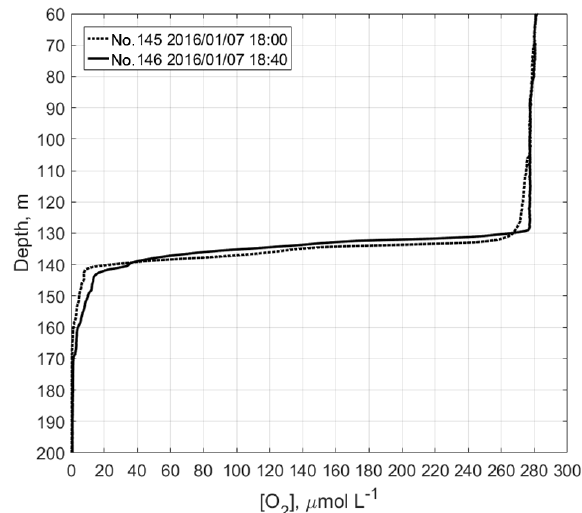
Figure 6. Example of two profiles [O 2 ] j ( z ), where z is the depth and j is the profile number, j = 145 and 146, when the oxygen in- ventory below the σ (cid:50) = 14kgm − 3 isopycnal was extremely low: I σ 14 < 3 . 5molm − 2 . The profile numbers, dates, and times are shown in the top left corner. The odd-numbered profiles were taken when the profiling probe was moving up, and the even-numbered profiles were taken when the profiling probe was moving down. Due to the time lag of the oxygen sensor, a profile obtained during the de- scent has slightly different curvatures compared with that obtained during the ascent, particularly at the upper and lower boundaries of the